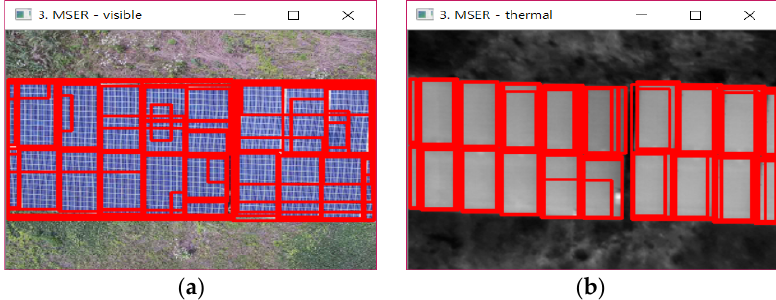
Figure 8. MSER algorithm without consideration of module size: ( a ) result of visible image gray MSER algorithm; ( b ) result of thermal image MSER algorithm.